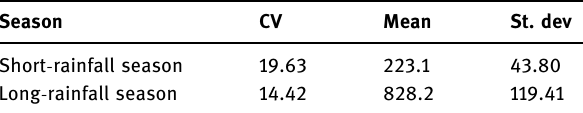
Table 4: Seasonal mean rainfall and CV te ff crop growing areas